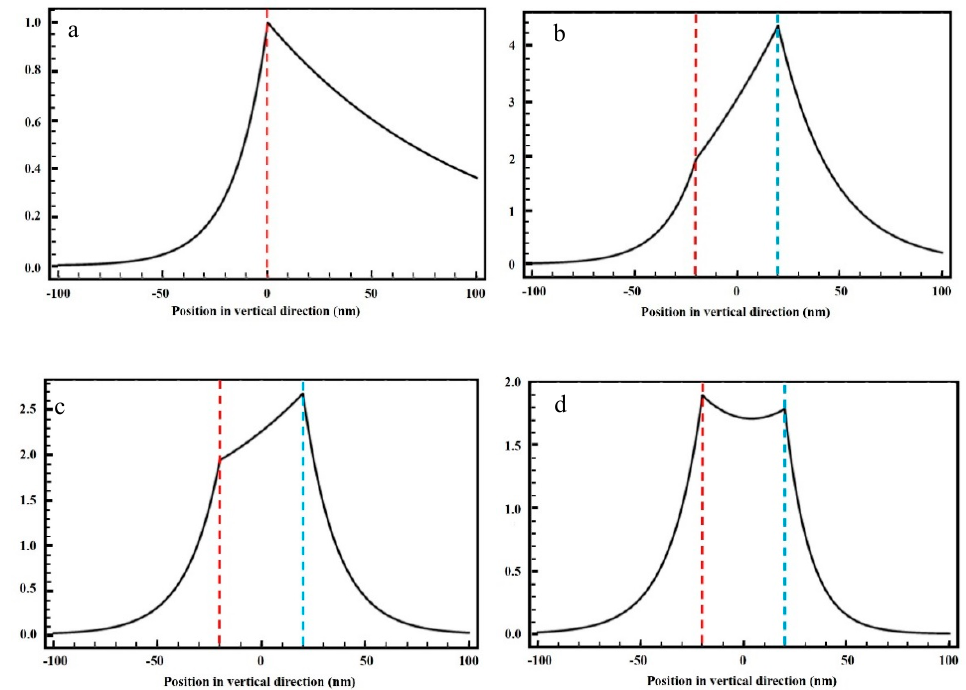
Figure 3. Surface plasmon polaritons (SPPs) distribution of the dimensionless H y component in the photoresist layer with different materials. ( a ) No metal reflector, ( b ) silver reflector, ( c ) chromium reflector, and ( d ) aluminum reflector.